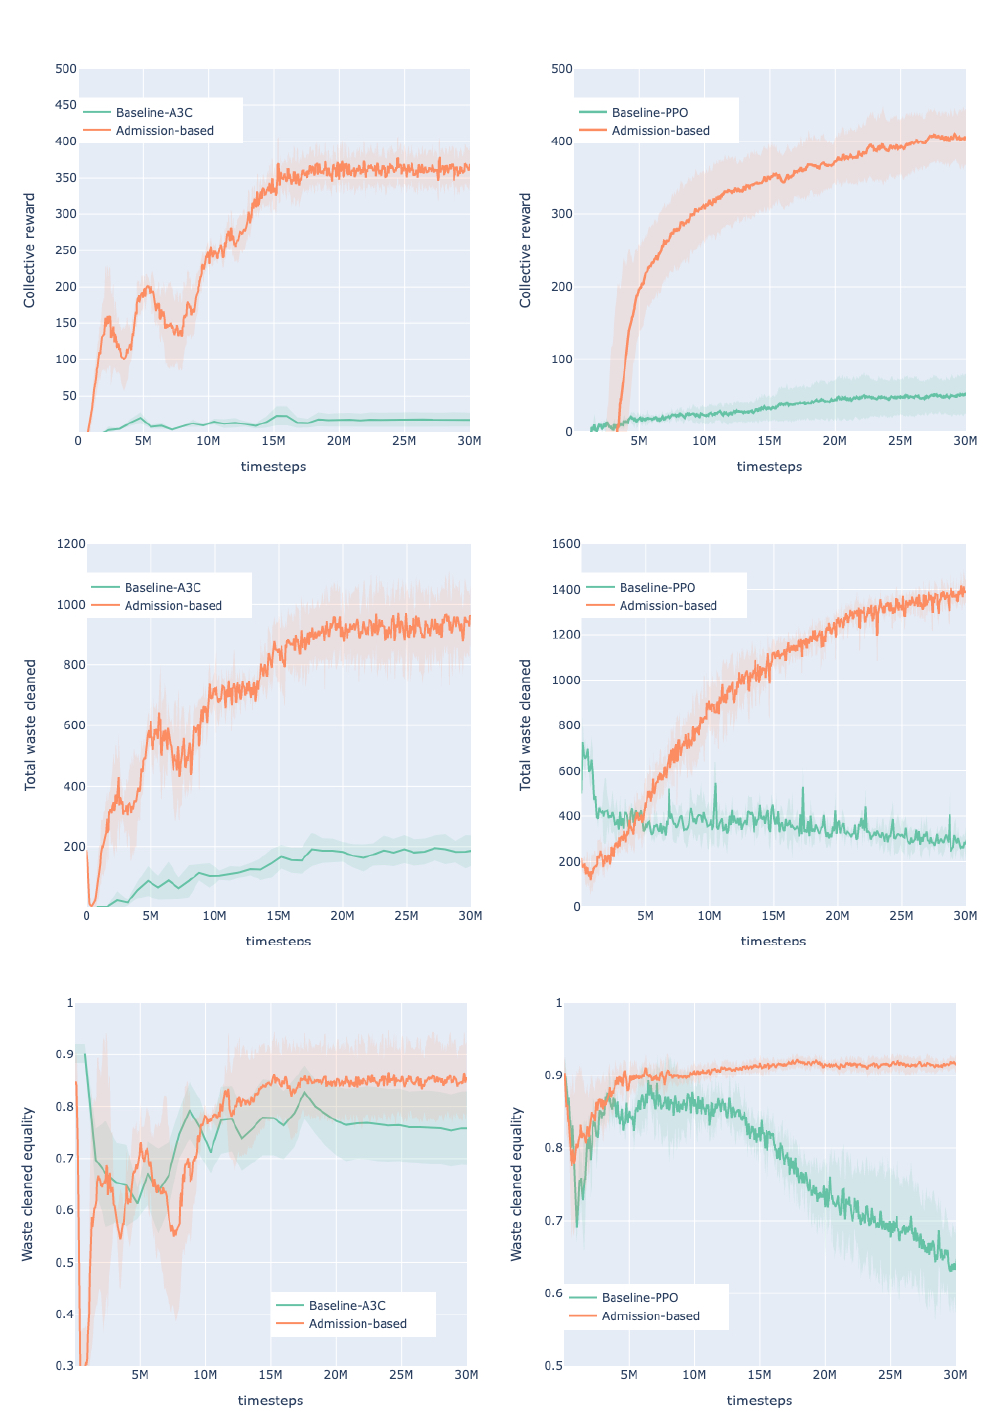
Figure 4. The performance of the Admission algorithm in various metrics in Cleanup. The three images on the left and the three images on the right are the results of our algorithm applied to A3C and PPO,